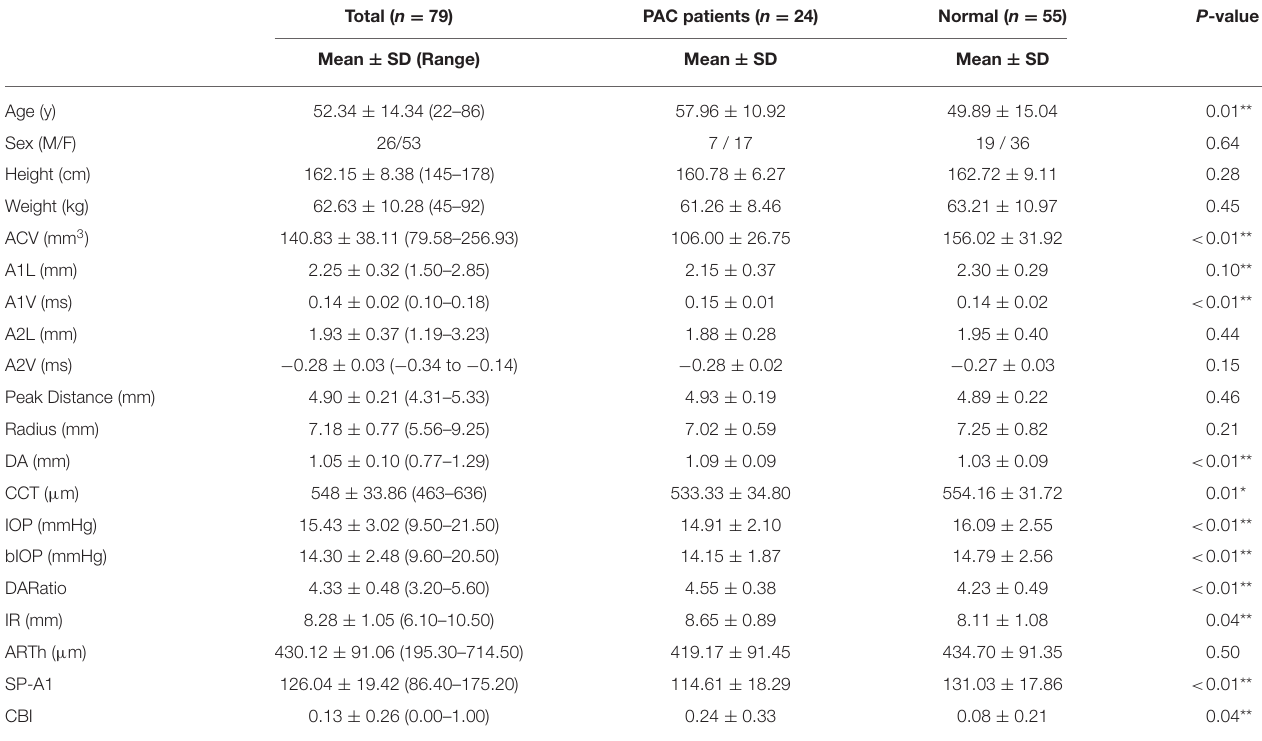
TABLE 2 | Demographics, ACV and corneal biomechanical parameters of the participants, and comparisons between the PAC patients and the normal